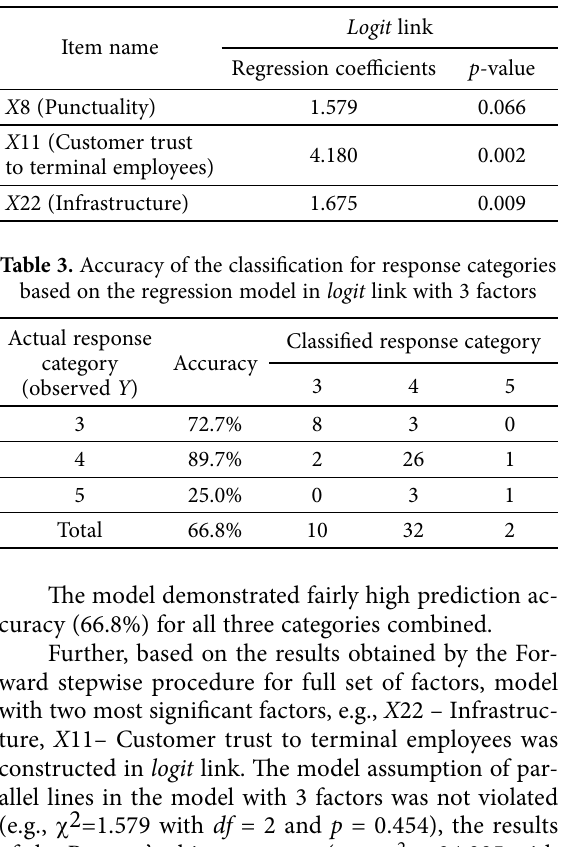
Table 2. Explanatory variables associated with the overall quality of service based on the model with 3 factors in the logit link